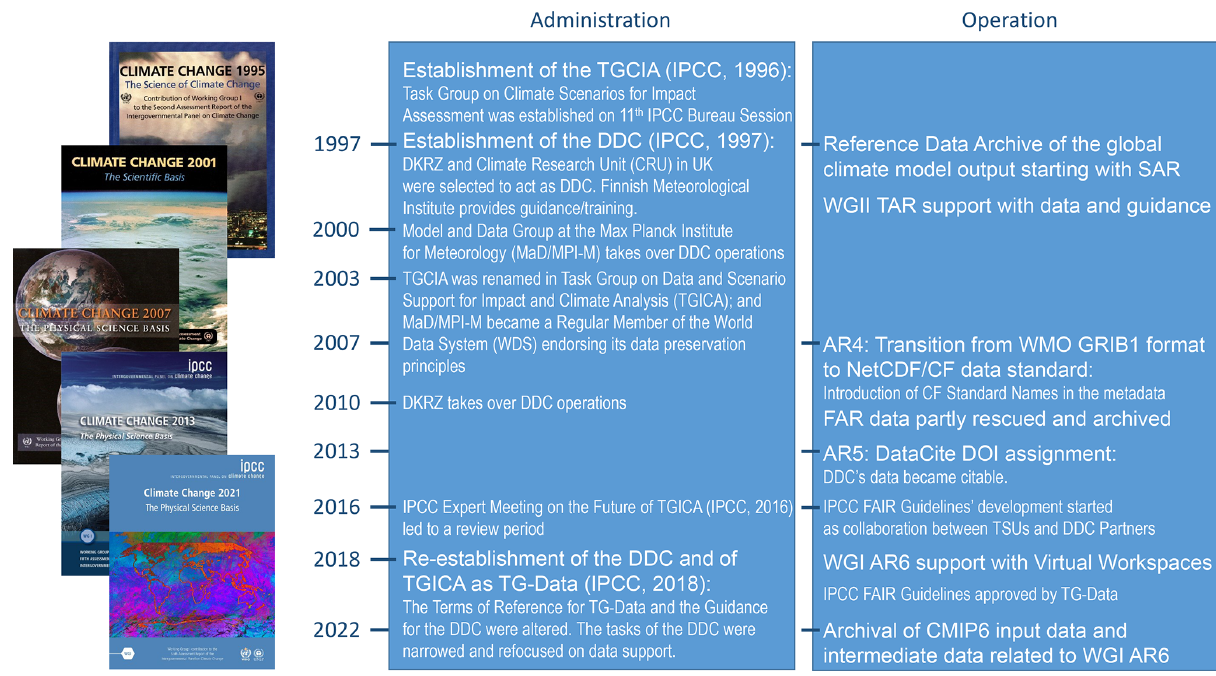
Figure 2. IPCC DDC history and main achievements of the DDC Partner DKRZ over the past 25 years (images from cover pages of the IPCC ARs starting with SAR